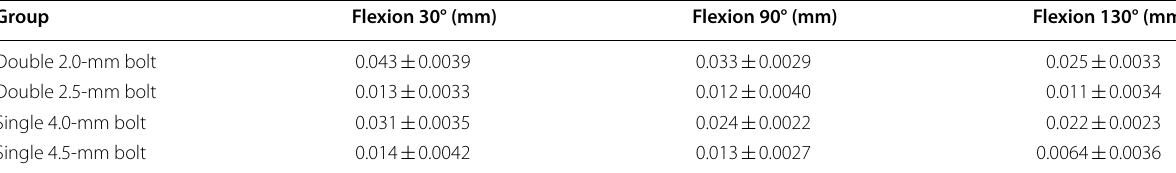
Table 2 Comparing the distribution of total deformation of the fixation bolt between groups